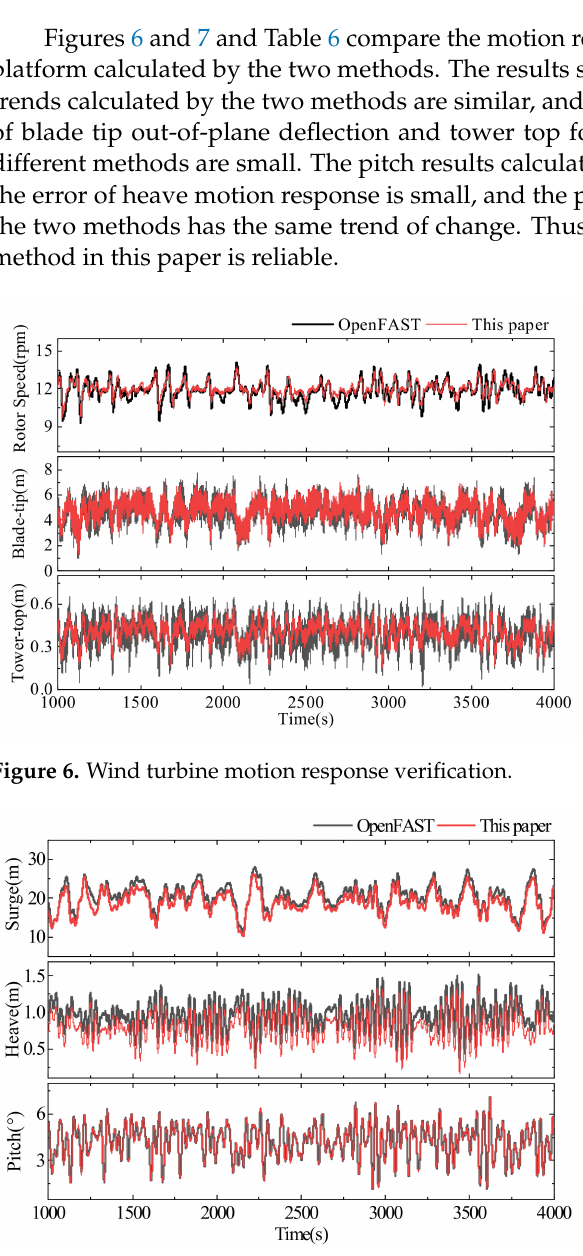
Figure 7. Platform motion response verification. Table 6. The statistics of two calculation